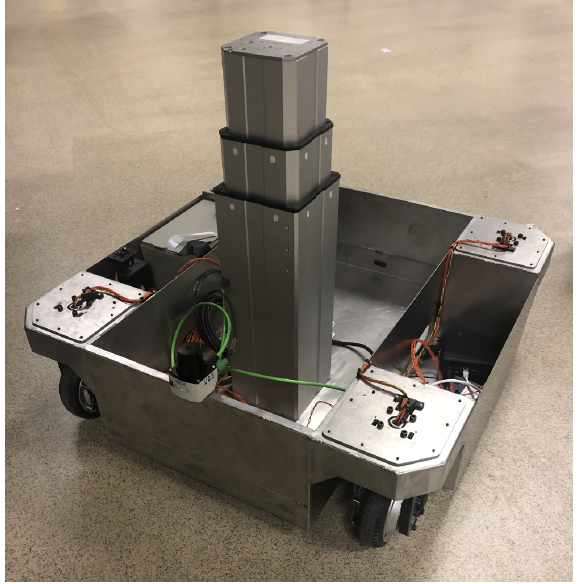
Figure 1. Robotic platform used in the evaluation. It has four combined steer and drive wheels located at each corner. The onboard computer is an Intel NUC